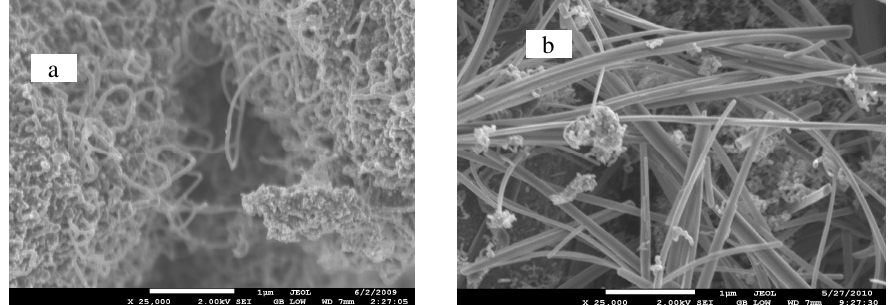
Figure 2. FE-SEM image of carbon nanotubes prepared from (a) Co/Zn/Al and (b) Fe/Ni/Al